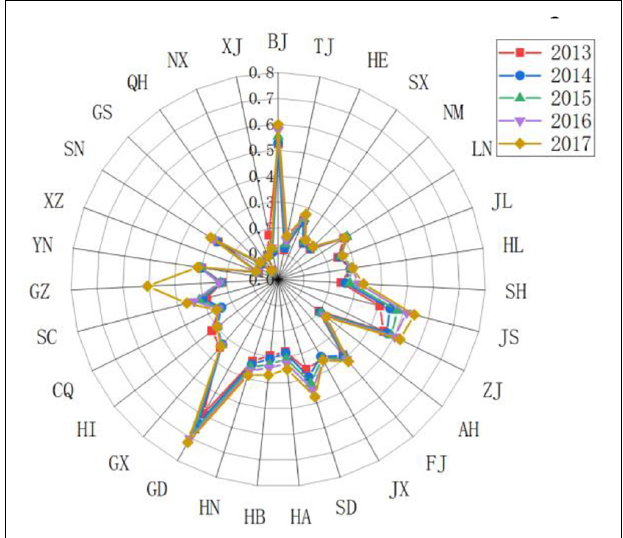
FIGURE 4 | Comparing the scores of the sports development resilience pressure subsystem in various provinces in China.